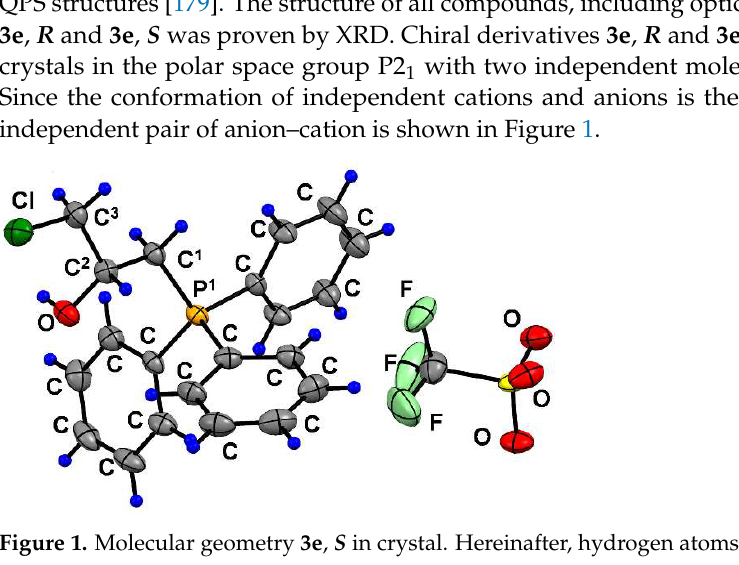
Figure 1. Molecular geometry 3e , S in crystal. Hereinafter, hydrogen atoms are shown as spheres of arbitrary radius. Thermal ellipsoids are presented with a probability of 50%. The cell contains two independent molecules. To simplify, only one molecule is shown.